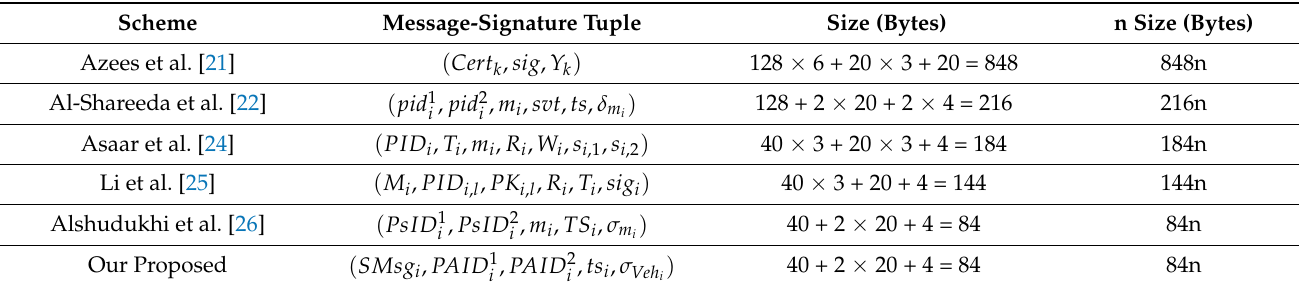
Table 5. The Comparison of Communication